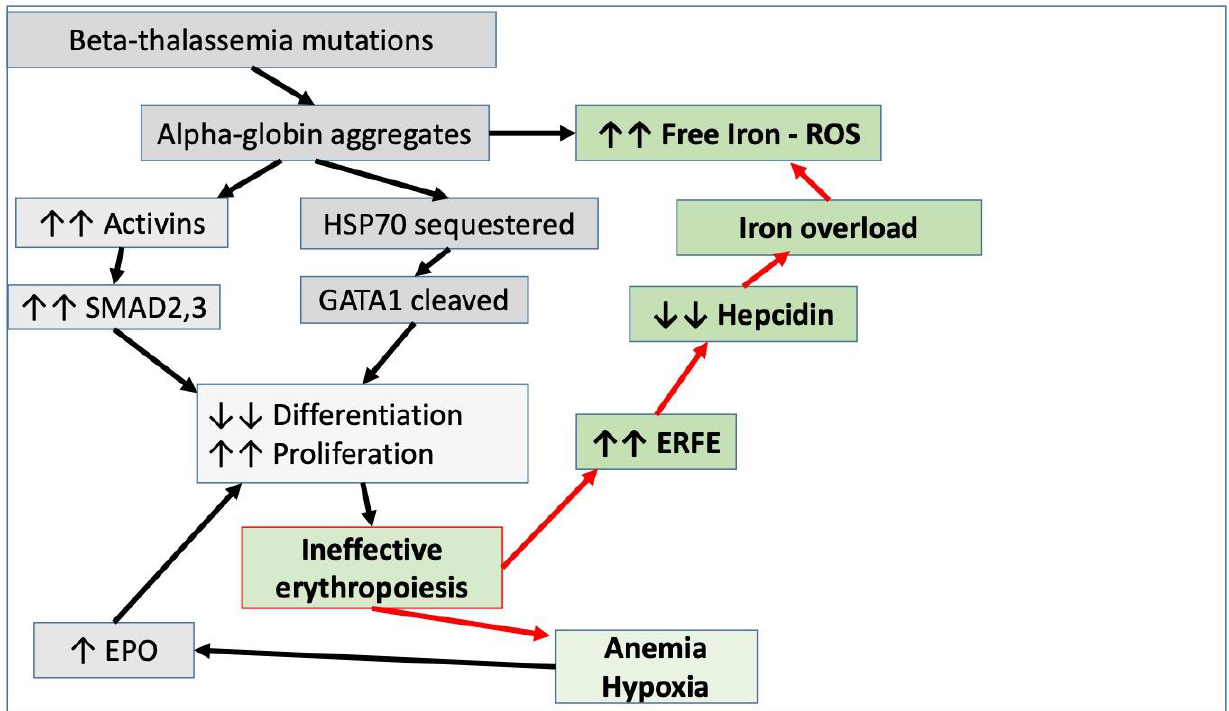
Figure 1. Central role of ineffective erythropoiesis in hepcidin cascade in thalassemia (ERFE = erythroferrone; EPO = erythropoietin; ROS = reactive oxygen